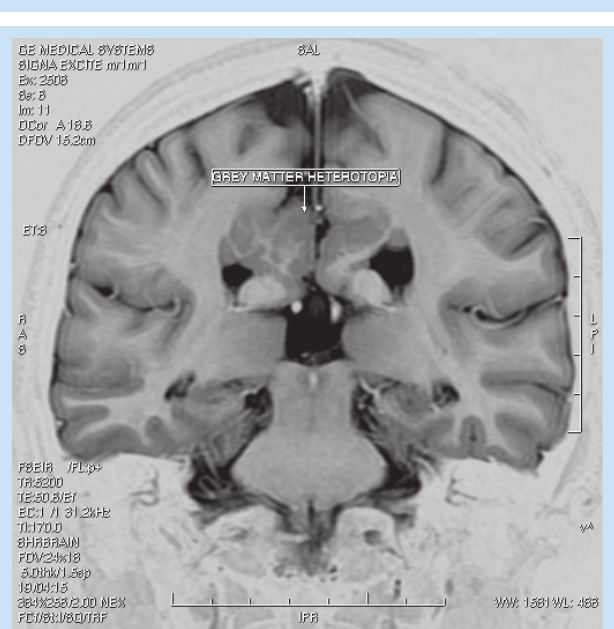
heterotopia.Fig. 3c. A coronal post-contrast zoomed T1W MRI scan demonstrating the hypoplastic optic nerves. The pituitary stalk was not